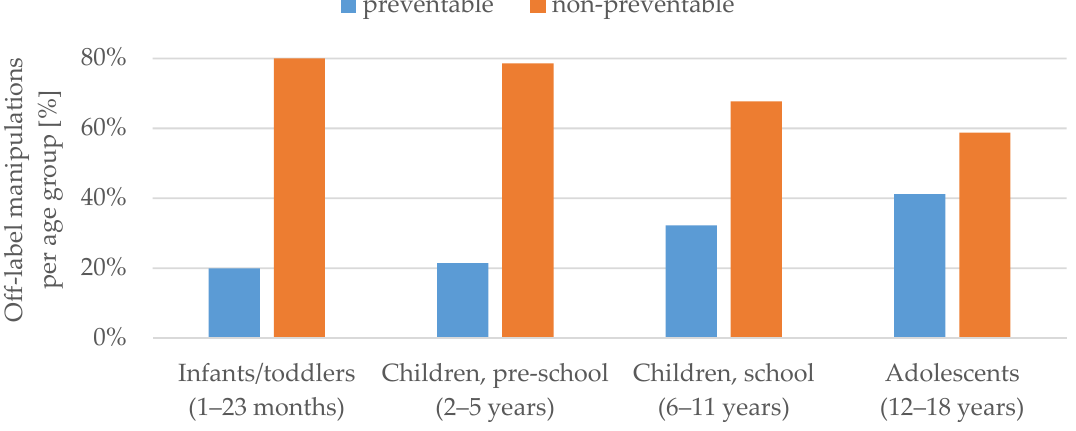
Figure 2. O ff -label manipulations per age group (%) classified by preventability. Figure 2. Off ‐ label manipulations per age group (%) classified by preventability.